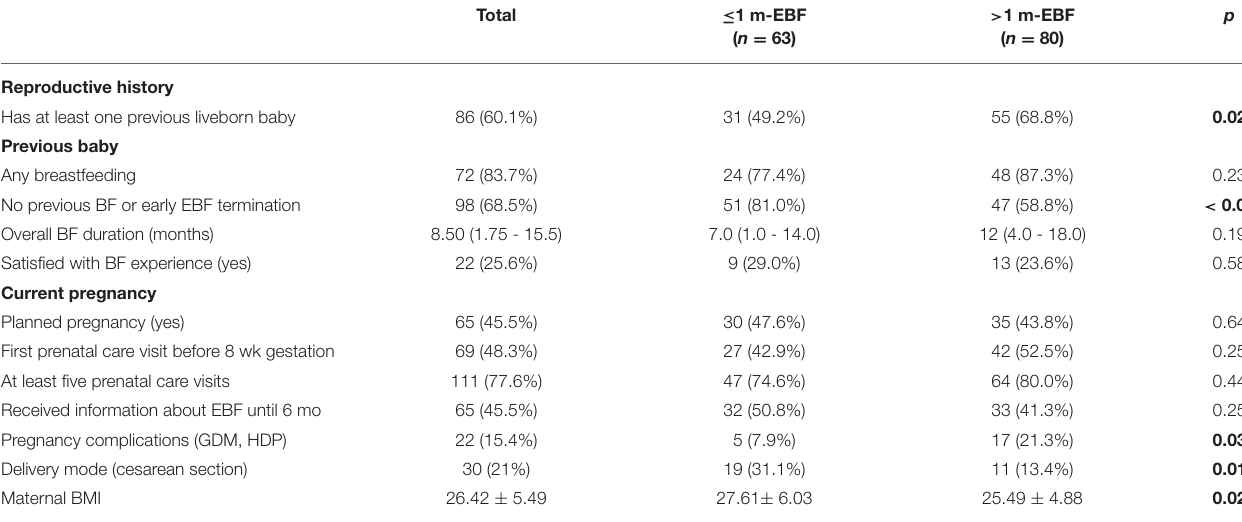
TABLE 2 | Reproductive history and last pregnancy factors.